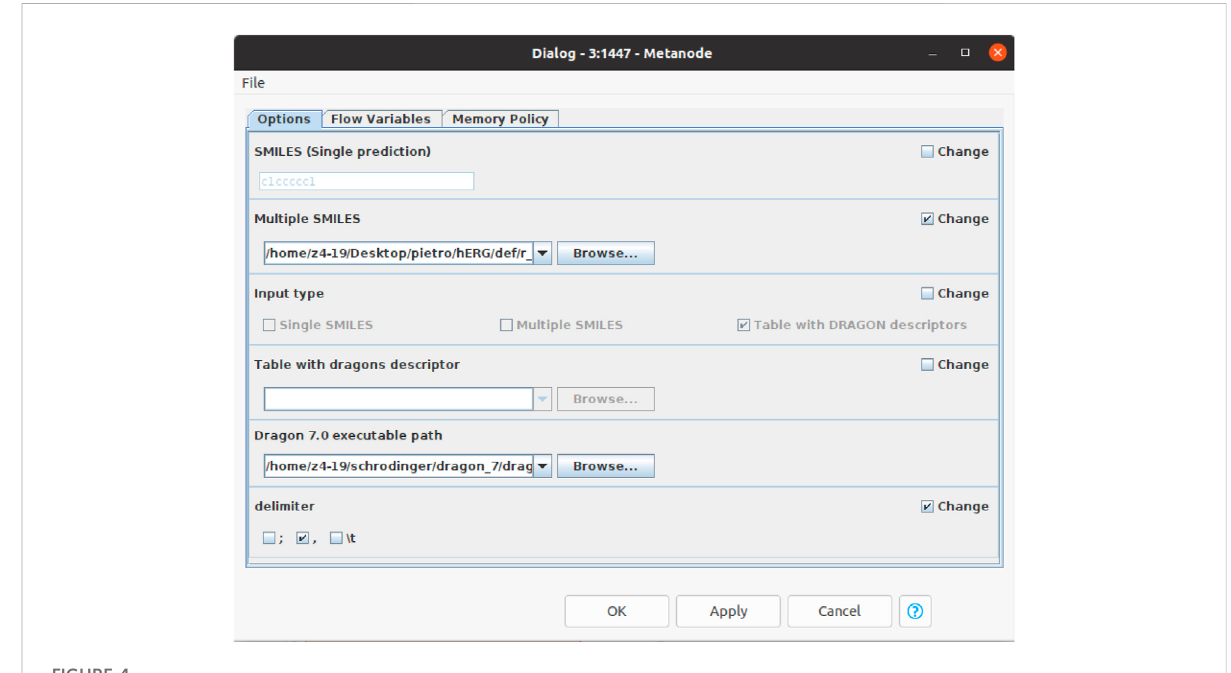
FIGURE 4 Dialog box to set up the calculation using the KNIME work fl ow.